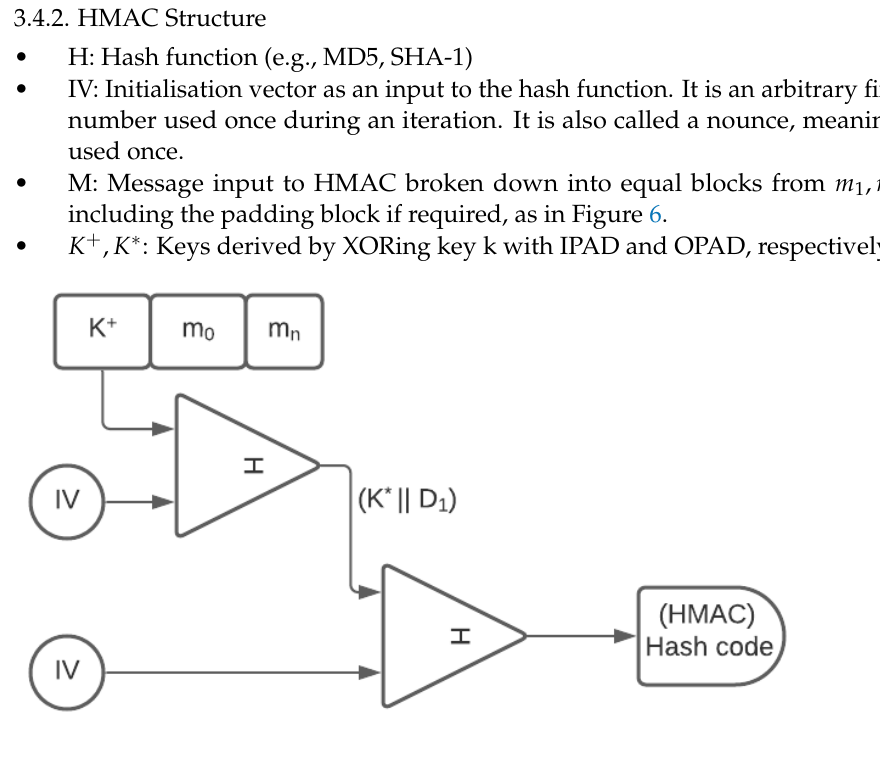
Figure 6. HMAC generation. Adapted from